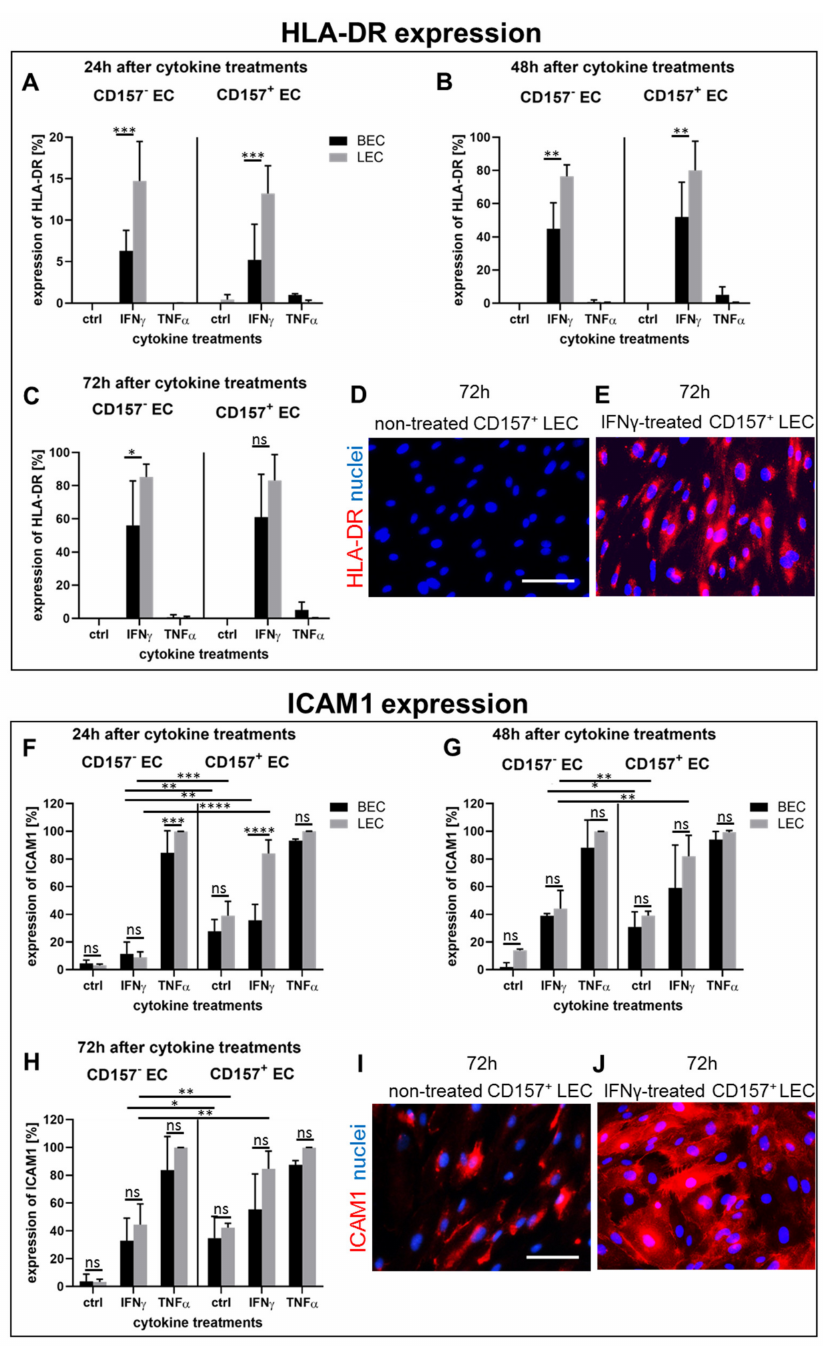
Figure 5. Induction of HLA-DR and ICAM1 expression in CD157 − and CD157 + BEC and LEC in vitro ( A – E ) The protein expression of HLA-DR before and after 24-h ( A ), 48-h ( B ), and 72-h ( C , E ) stimulation of CD157 − and CD157 + BEC and LEC with IFN γ and TNF α in vitro (n = 3). The expres- sion level was assessed by flow cytomeric analysis ( A – C ) and immunofluorescence staining ( D , E ). ( F – J ) The expression of ICAM1 before after 24-h ( F ), 48-h ( G ), and 72-h ( H , J ) stimulation of CD157 − and CD157 + BEC and LEC with IFN γ and TNF α in vitro. The expression level was assessed by flow cytometric analysis ( A – C ) and immunofluorescence staining ( I , J ) (n = 3). **** indicates p < 0.0001 extremely significant, *** indicates p < 0.001 extremely significant, ** indicates p < 0.01 very significant, * indicates p < 0.05 significant, ns indicates p ≥ 0.05 not significant. Statistical tests were performed using two-way ANOVA. Scale bars: 50 µ